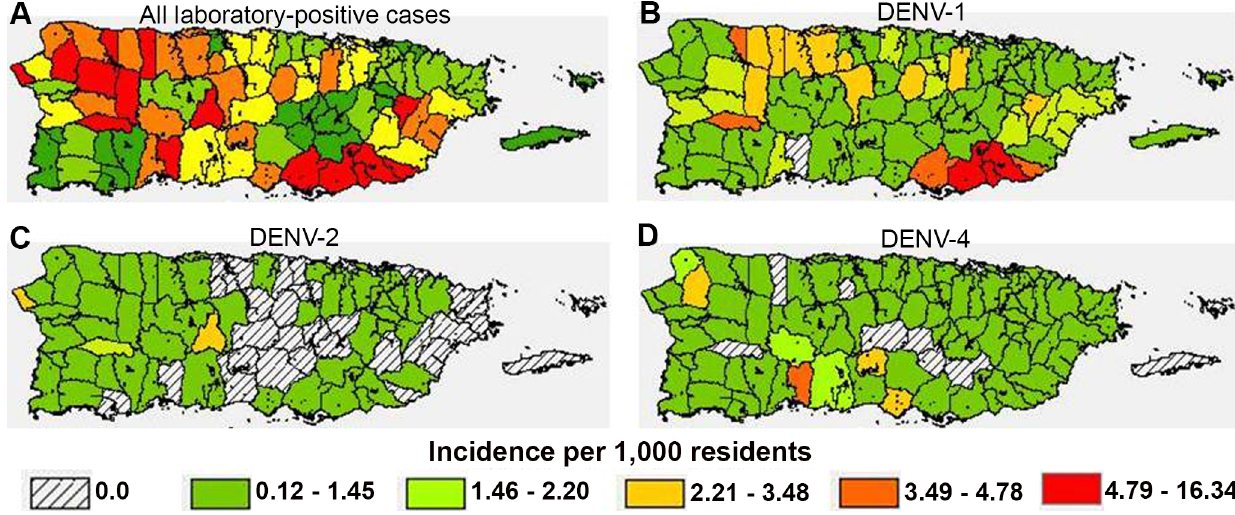
Figure 2. Rates of laboratory-positive cases by municipality, Puerto Rico, 2010. Rates were calculated by dividing case numbers by municipality-specific populations and grouping by quintile of rate of all laboratory-positive cases. Rates shown are: ( A ) All laboratory-positive cases; or laboratory-positive cases with DENV-1 ( B ), DENV-2 ( C ), or DENV-4 ( D ) detected by RT-PCR.